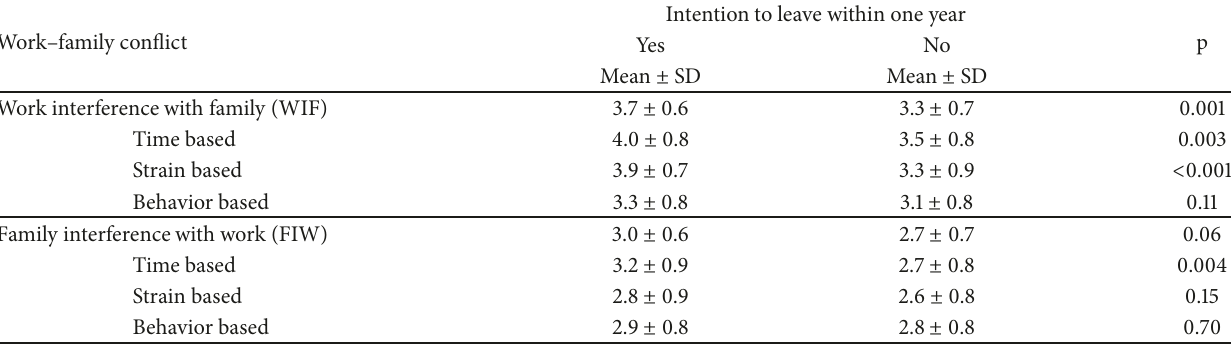
Table 4: Relationship between work–family conflict and intention to leave emergency department (ED) practice within one year.